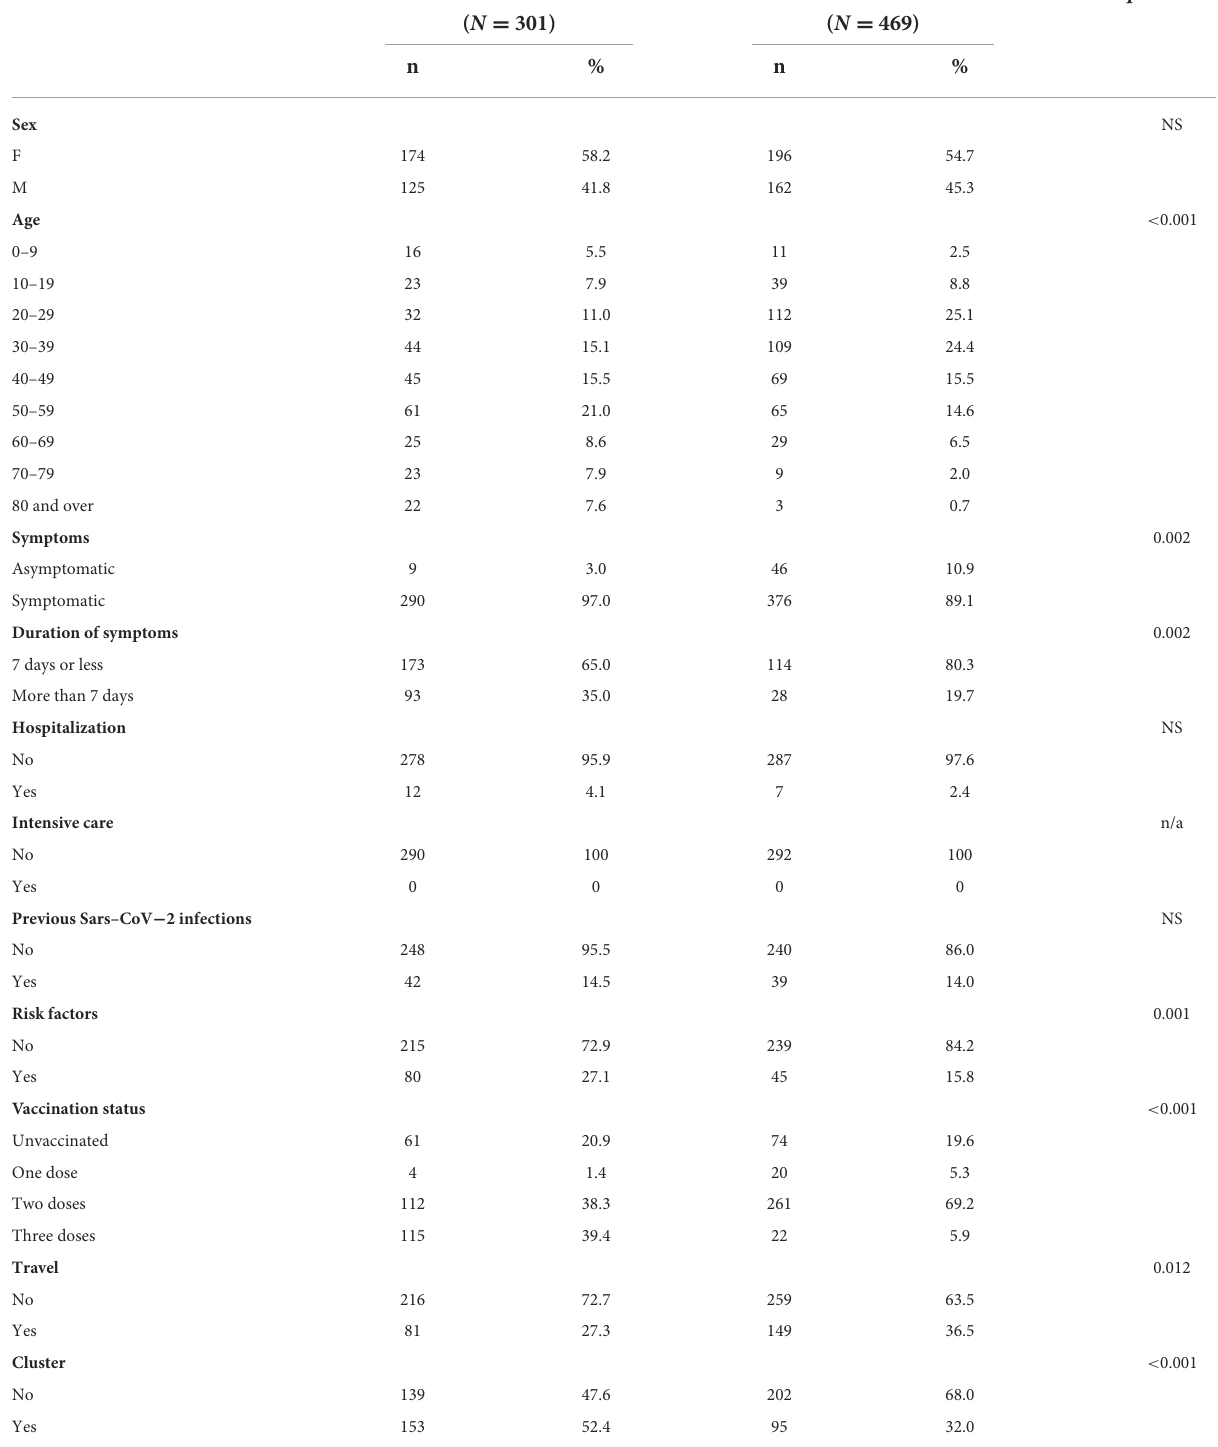
TABLE 1 Characteristics of confirmed (by sequencing) or possible (linked to a confirmed case) cases of infection by BA.4/BA.5 and comparison with BA.1 cases. Characteristics BA.4/BA.5